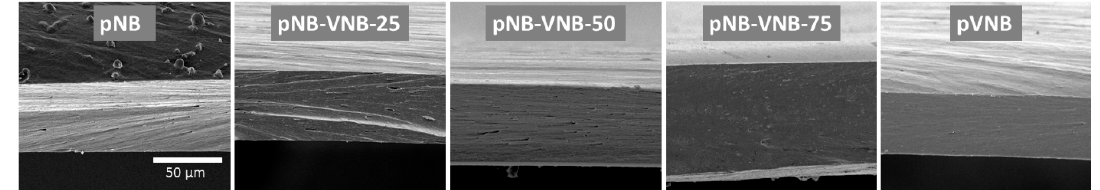
Figure 5. SEM pictures of the cross-sections of the polynorbornene membranes. All membranes were imaged using the same magnification (×500). Larger images and images with higher magnification can be found in the supporting information.